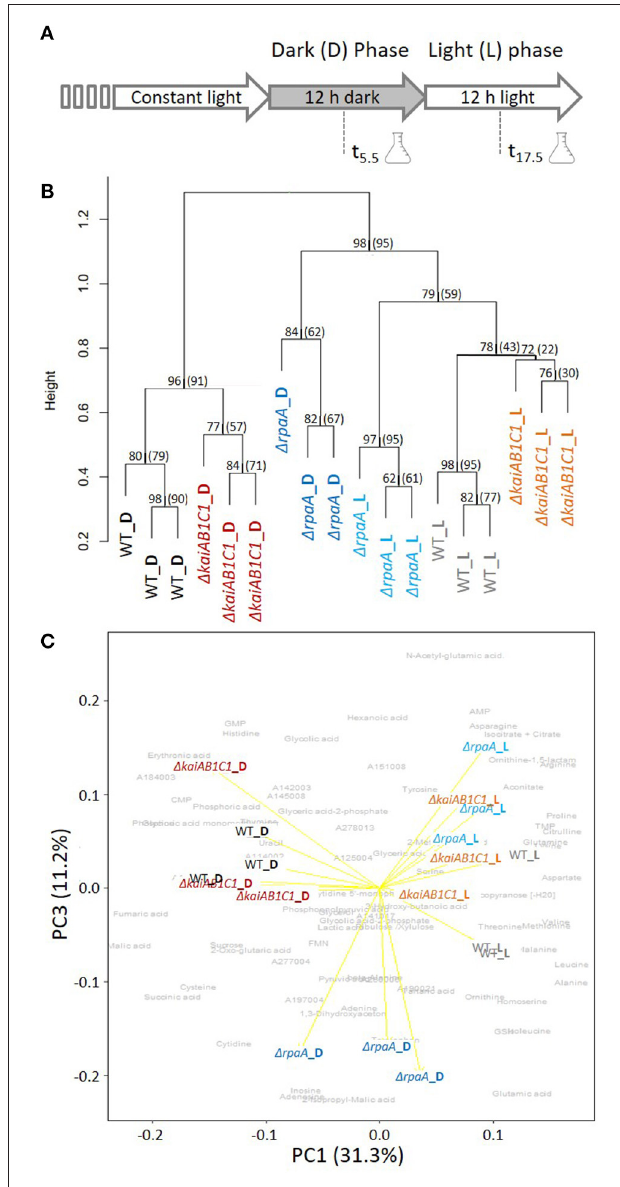
FIGURE 4 | Global analysis of the metabolic L/D switch in the 1 kaiAB1C1 and 1 rpaA mutants. (A) Design of the two-factorial entrainment experiment. Wild-type and mutant cells, i.e., the first experimental factor (genotype), were precultivated under continuous light, divided into independent cultures of OD 750 = 0.6 in ambient air, and sampled in the middle of the first 12-h D phase and first 12- h L phase after entrainment, i.e., the second experimental factor (illumination). Three independent replicate cultures in each phase were analyzed by a quantitative targeted LC-MS analysis and non-targeted GC-MS metabolome profiling of the primary metabolome. (B) Hierarchical cluster analysis (HCA) of mutant and wild-type metabolomes. Annotated LC- and GC-MS metabolite data separately maximum scaled and then combined, log-transformed, autoscaled, and clustered using Pearson’s correlation distance metric and average linkage. HCA includes a scale of the node height and bootstrap-support analysis by 1,000 iterations. The values represent the “approximately unbiased” bootstrap probability, and in brackets, the conventional bootstrap probability obtained using the “pvclust” R package is shown. Values of 100 represent the highest node probability. (C) Principal component analysis (PCA) of the same data. PC1 and PC3 demonstrate